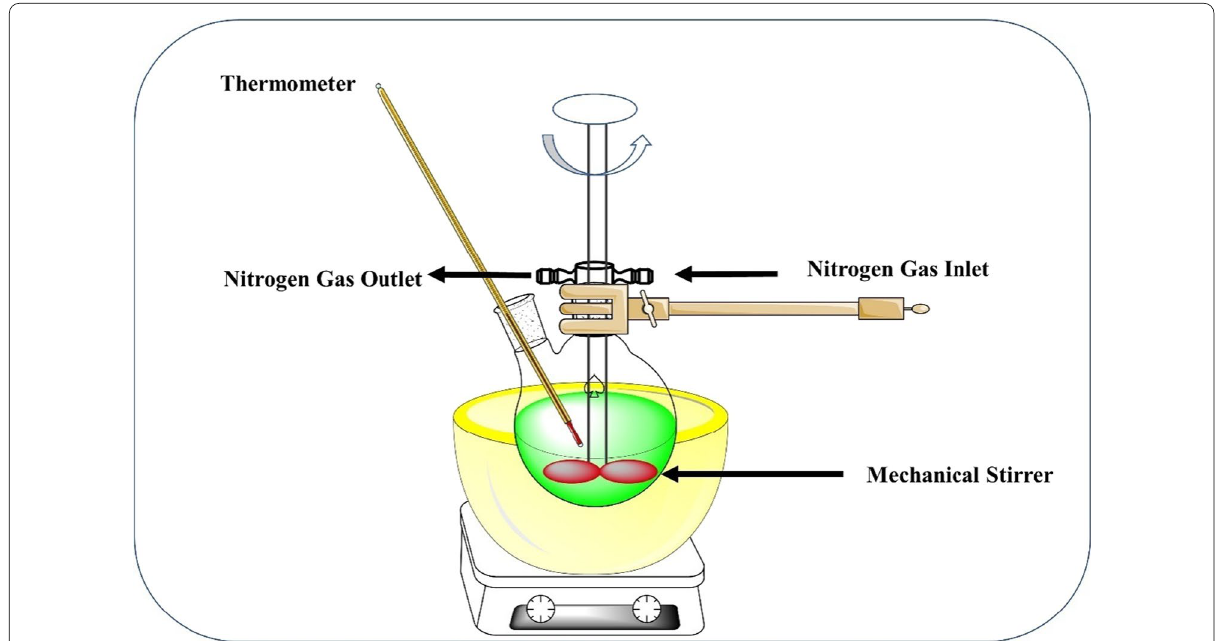
Fig. 5 Preparation of liquid–liquid suspension polymerization using reaction